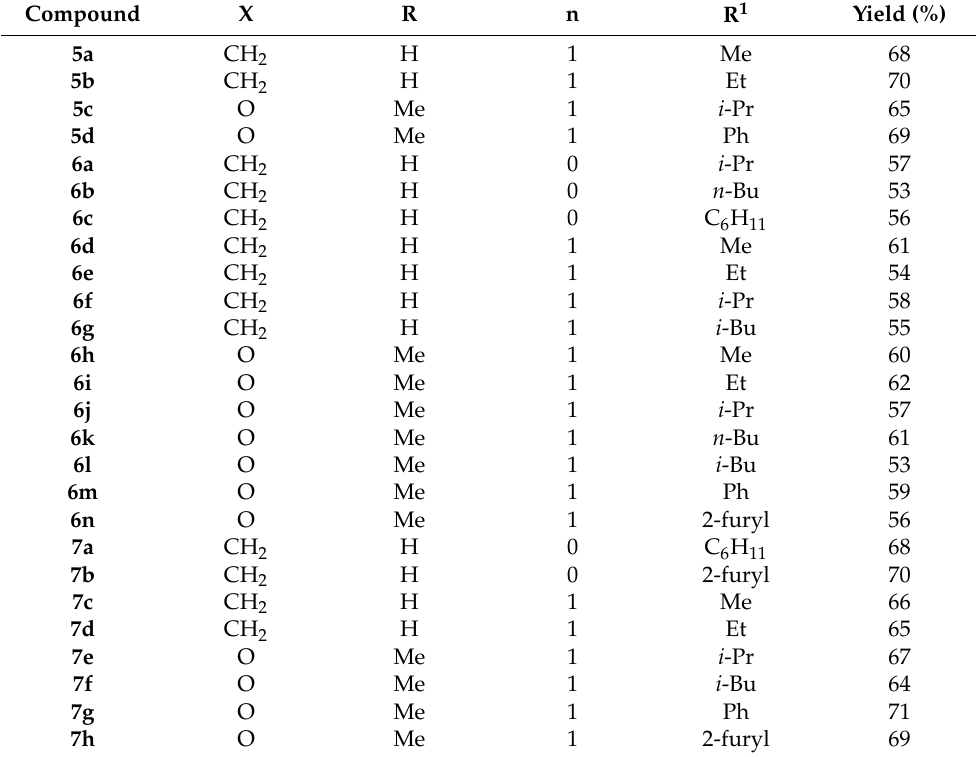
Table 1. Furo[3,2- d ]pyrrolo[1,2- a ]pyrimidines 5 , furo[3,2- d ]pyrido[1,2- a ]pyrimidines 6